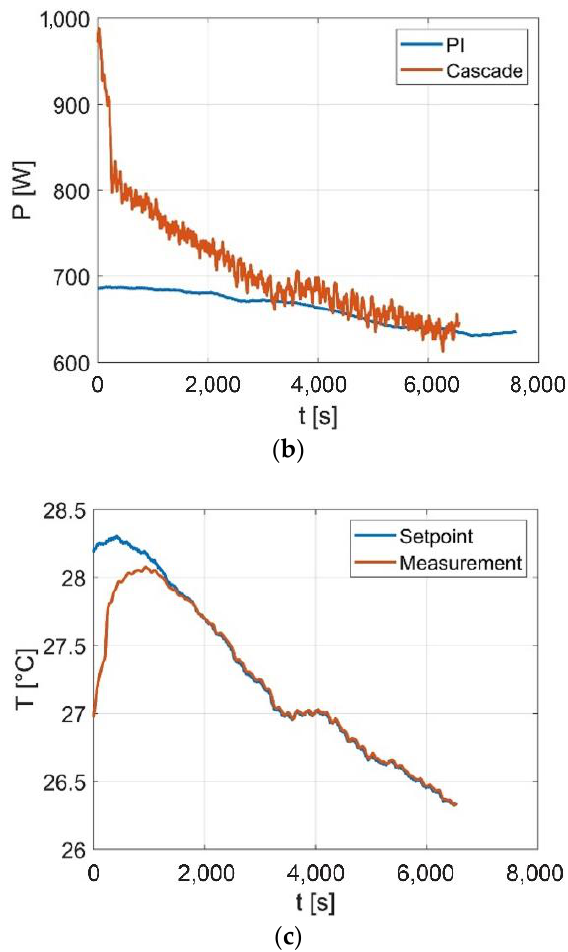
Figure 26. Experimental results of adjusting the dryness of the tape after changing the set value of dryness by 5%. Dryness waveforms ( a ), heating power waveforms ( b ), and cylinder surface temper- ature waveforms during cascade control ( c ).